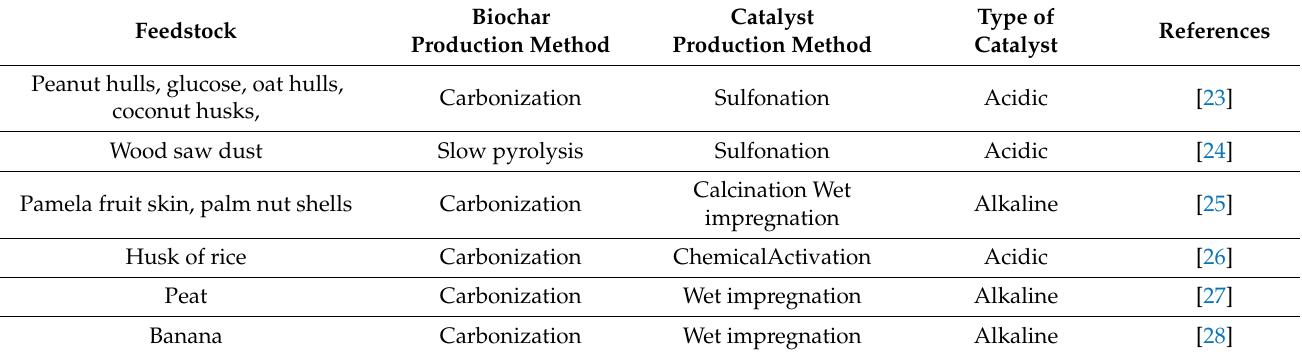
Figure 1. Methods of producing biochar-based catalysts [22]. Table 1. Producing biochar and biochar-based catalysts through different methods and feedstocks.